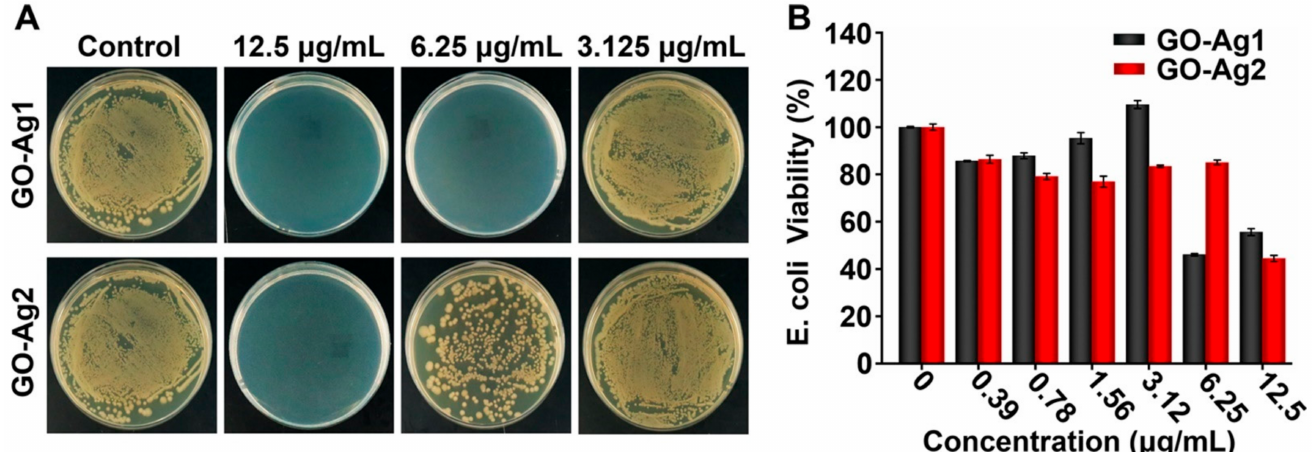
Figure 4. Antibacterial activity of PEG/GO/Ag nanocomposites. ( A ) Bacterial colony formation of E. coli under different treatments. ( B ) Bacterial cell viability of E. coli exposed to nanocomposites with different sizes of Ag nanoparticles: GO-Ag1 (8 nm) GO-Ag2 (50 nm). Reprinted with permission from ref. [61]. Copyright 2021 Springer